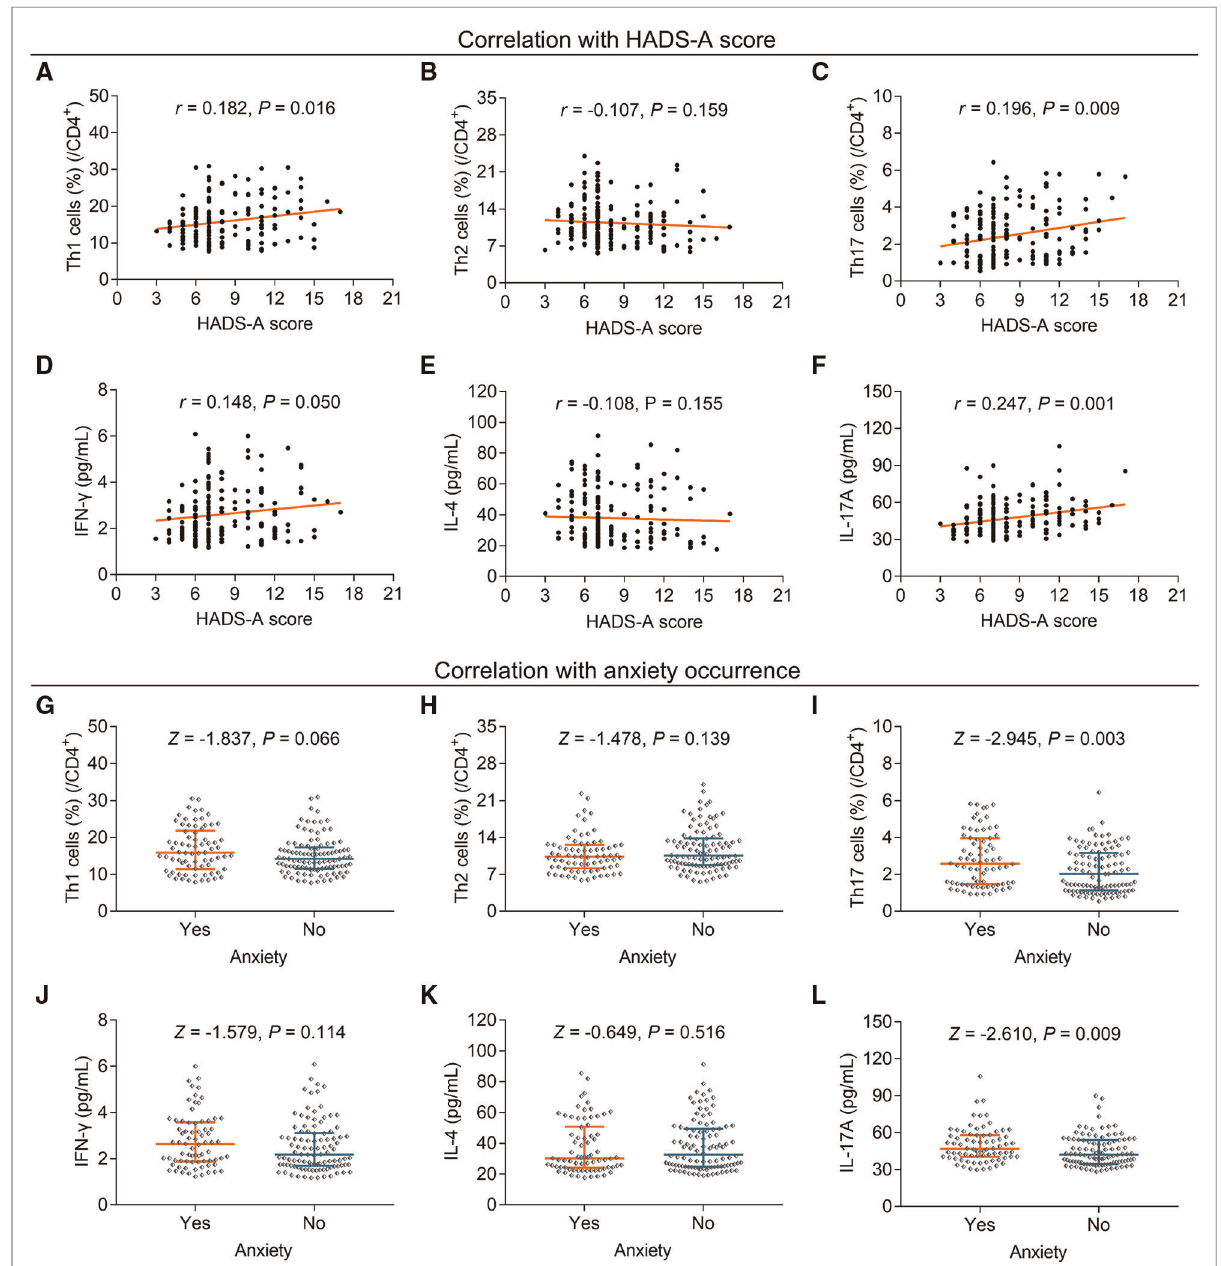
FIGURE 1 The association between Th1, Th2, and Th17 cells and anxiety in elderly gastric cancer patients. The relationship between Th1 ( A ), Th2 ( B ), Th17 cells ( C ), IFN- γ ( D ), IL-4 ( E ), and IL-17A ( F ) and HADS-A score. The relationship between Th1 ( G ), Th2 ( H ), Th17 cells ( I ), IFN- γ ( J ), IL-4 ( K ), and IL-17A ( L ) and anxiety occurrence in elderly gastric cancer patients. Statistical methods: associations between continuous variables were analyzed using Spearman ’ s rank correlation test; the levels of Th cells and cytokines between patients with or without anxiety, depression, and cognitive impairment were determined using the Wilcoxon rank-sum